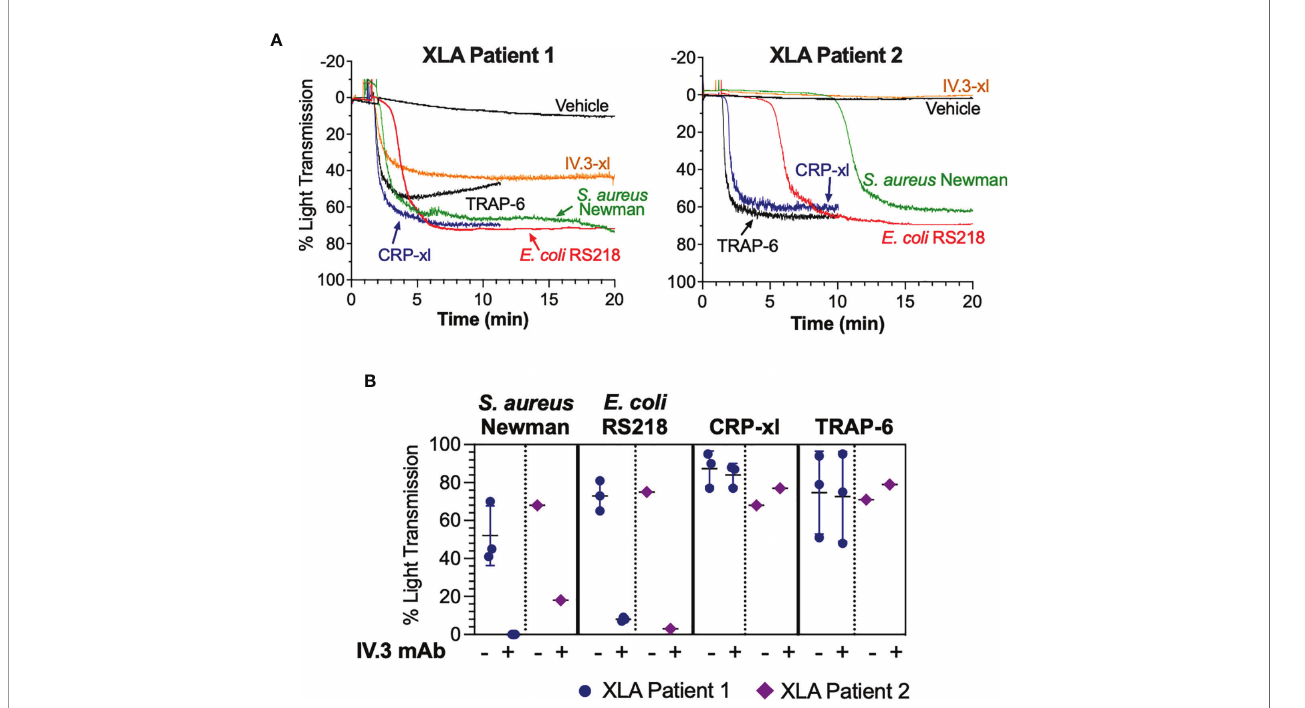
FIGURE 7 | Platelet responses to bacteria can take place in the absence of functional Btk. (A) Characterization of bacteria-induced aggregation of platelets from X- linked agammaglobulinemia patients. PRP samples from two XLA patients were stimulated with crosslinked IV.3 mAb (IV.3-xl; 4 m g/ml IV.3 mAb followed by 30 m g/ml F(ab ’ ) 2 rabbit anti-mouse IgG), S. aureus Newman, E . coli RS218, 3 m g/ml CRP-xl, and 3 m M TRAP-6. Aggregation was measured by light transmission aggregometry. (B) PRP from XLA patients was incubated with 20 m g/ml IV.3 mAb (to inhibit Fc g RIIA) or vehicle, before stimulation with either S. aureus Newman, E. coli RS218, 3 m g/ml CRP-xl or 3 m M TRAP-6. Aggregation was measured by light transmission aggregometry. Patient 1 (n=3, in different days) had a missense mutation in codon 28 affecting the Btk pleckstrin homology domain, which causes lack of Btk function. Patient 2 (n=1) had a mutation in exon 3 resulting in absence of Btk